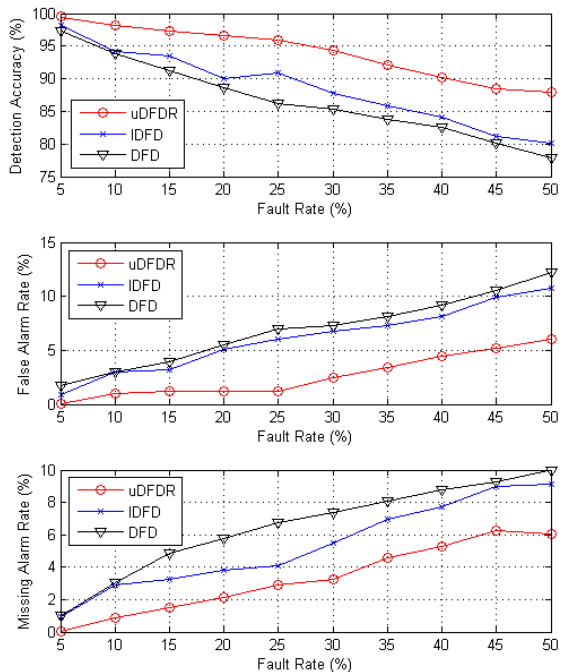
Figure 7. Detection effects under 80 working node